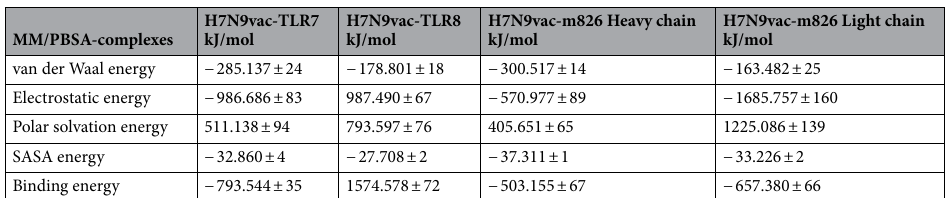
Table 6. MM/PBSA analysis of MD simulation results of H7N9vac-TLR7, H7N9vac-TLR8, H7N9vac-m826 Heavy chain and H7N9vac-m826 Light chain